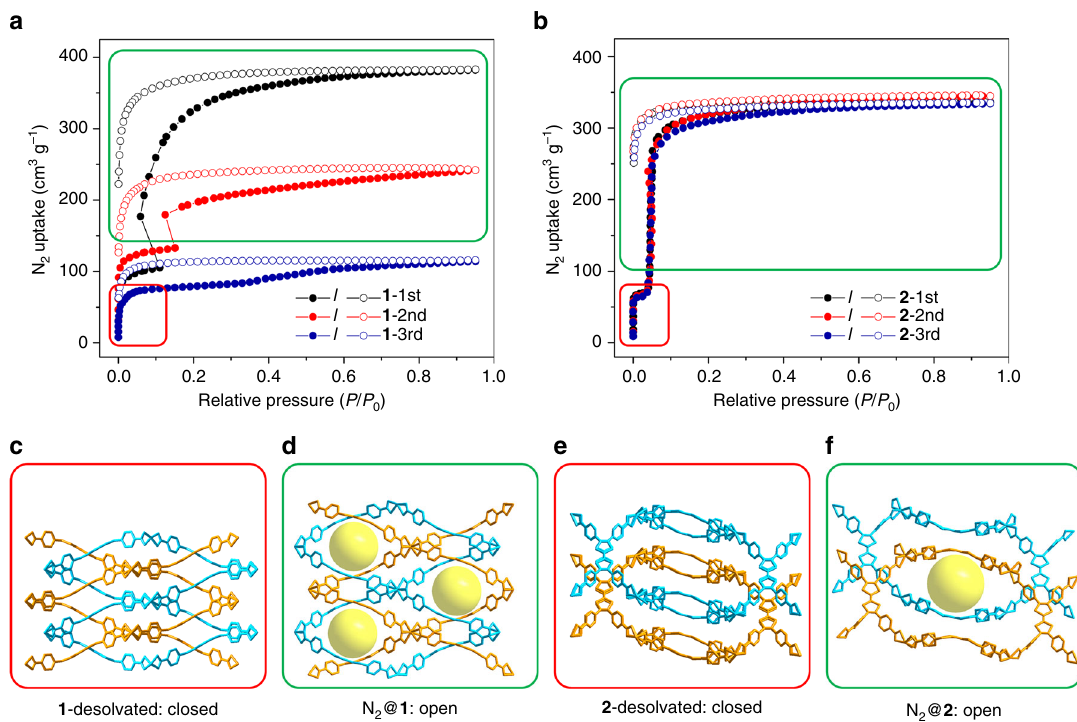
Fig. 2 Breathing behaviors of compounds 1 and 2 . a , b N 2 sorption isotherms of compounds 1 and 2 for three adsorption – desorption cycles; c , d simulated structures of 1 upon activation and N 2 adsorption; e , f single-crystal structure of 2 upon activation and N 2 adsorption. Two sets of interpenetrated networks were colored blue and orange. The cavities are highlighted by yellow